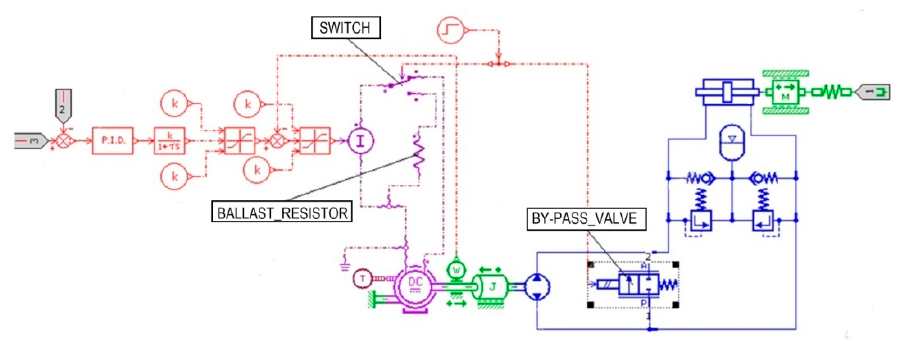
Figure 5. Failed servo scheme.